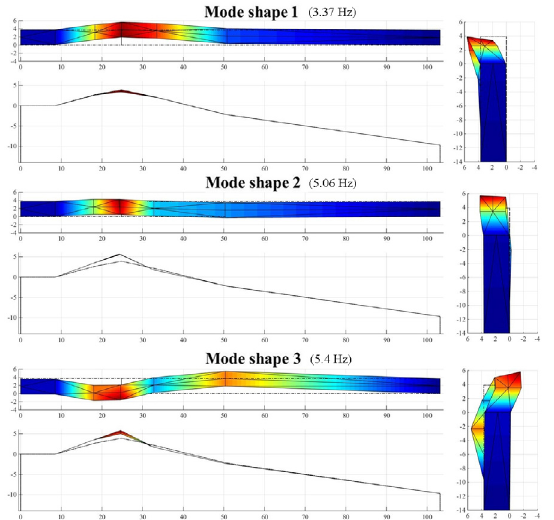
Figure 11. The first three mode shapes of the bridge evaluated experimentally: plane, frontal and lateral views. The gray line re- presents the undeformed shape.